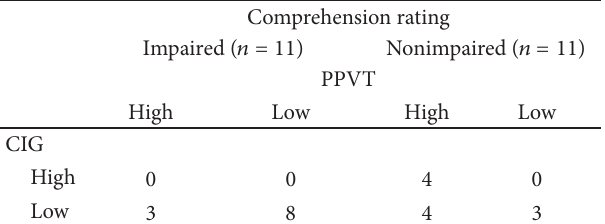
Table 4: Cross-tabulation of the number of patients scoring in the deficient range on CIG and PPVT-R against comprehension-deficit